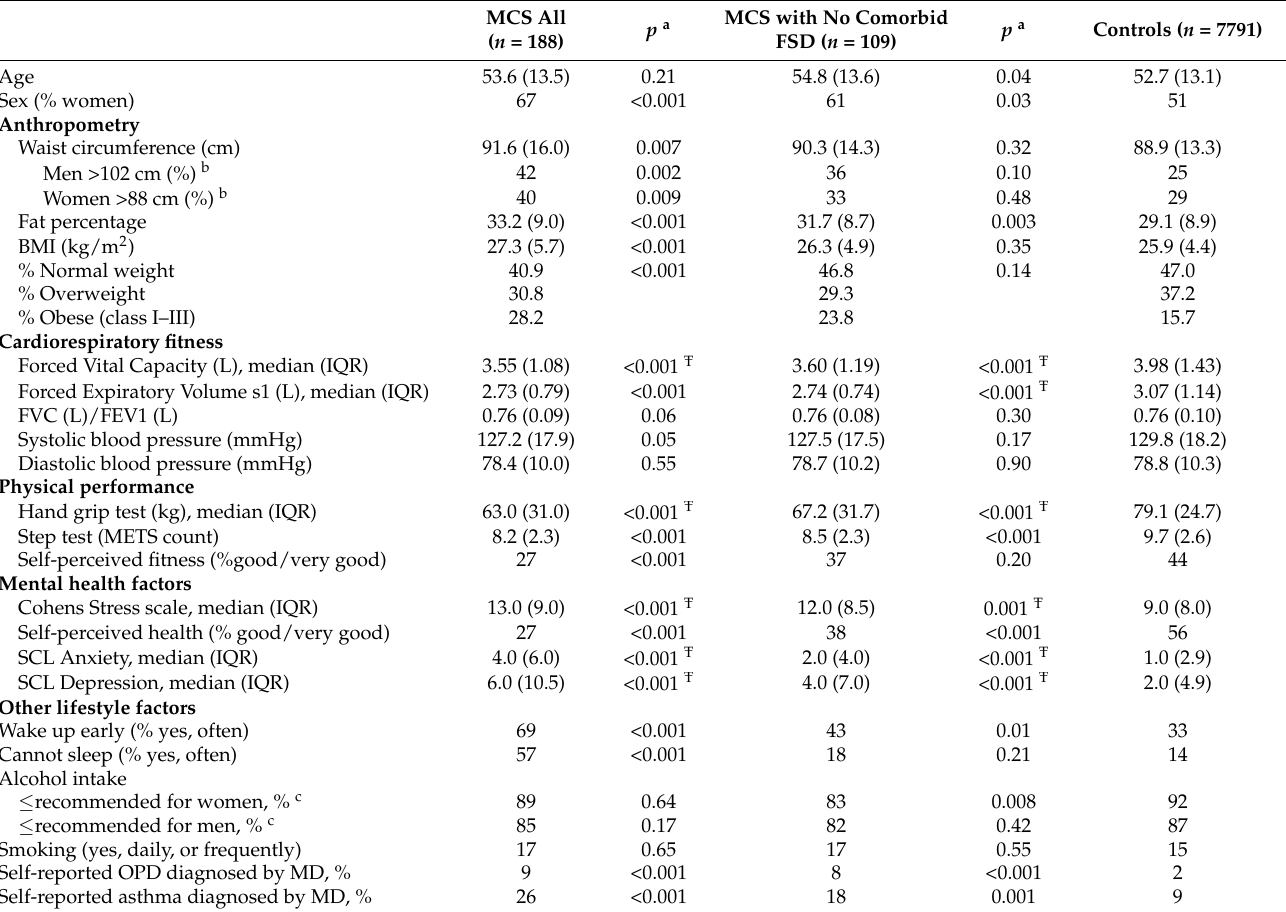
Table 1. Participant characteristics and distributions (mean (SD) is presented unless otherwise stated).